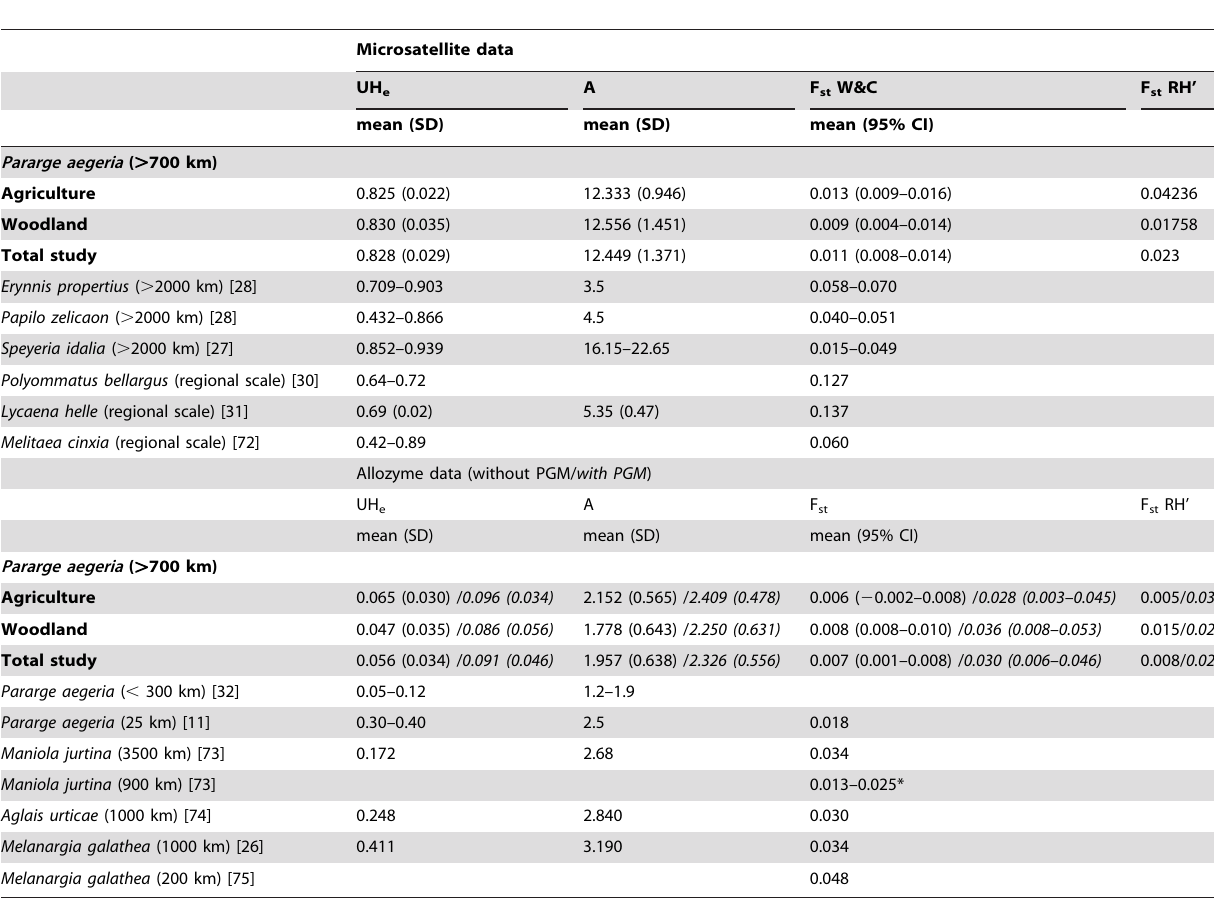
Table 1. Genetic diversity and differentiation in P. aegeria (bold) and other species, based on microsatellites and